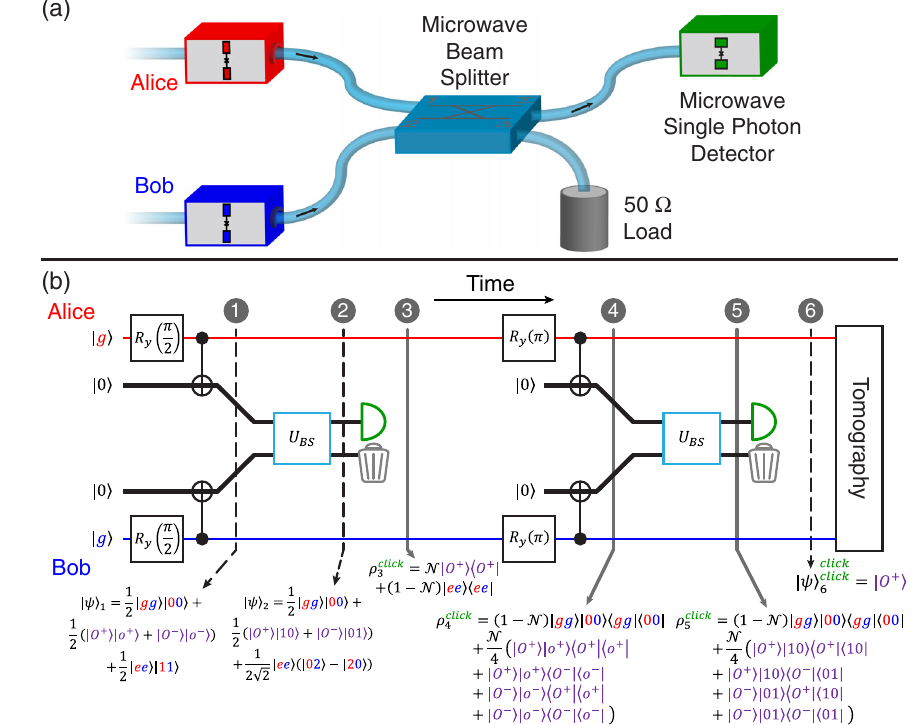
FIG. 1. Experiment and protocol schematic for remote entanglement of transmon qubits using flying single microwave photons. (a) Two superconducting 3D transmon qubits, Alice and Bob, are connected by coaxial cables to the two input ports of the microwave equivalent of a 50 = 50 beam splitter. One of the output ports of the splitter is connected to a microwave single-photon detector also realized by a 3D transmon qubit. The other port of the splitter is terminated in a cold 50 Ω load. (b) Quantum circuit diagram of the remote entanglement protocol, with the states of the quantum system at various steps. The Alice and Bob (red and blue) qubits are each ffiffiffi p 2 prepared in the state ð 1 = Þðj g iþj e iÞ by a single-qubit gate R y ð π = 2 Þ . They are then entangled with flying single photons (black) via